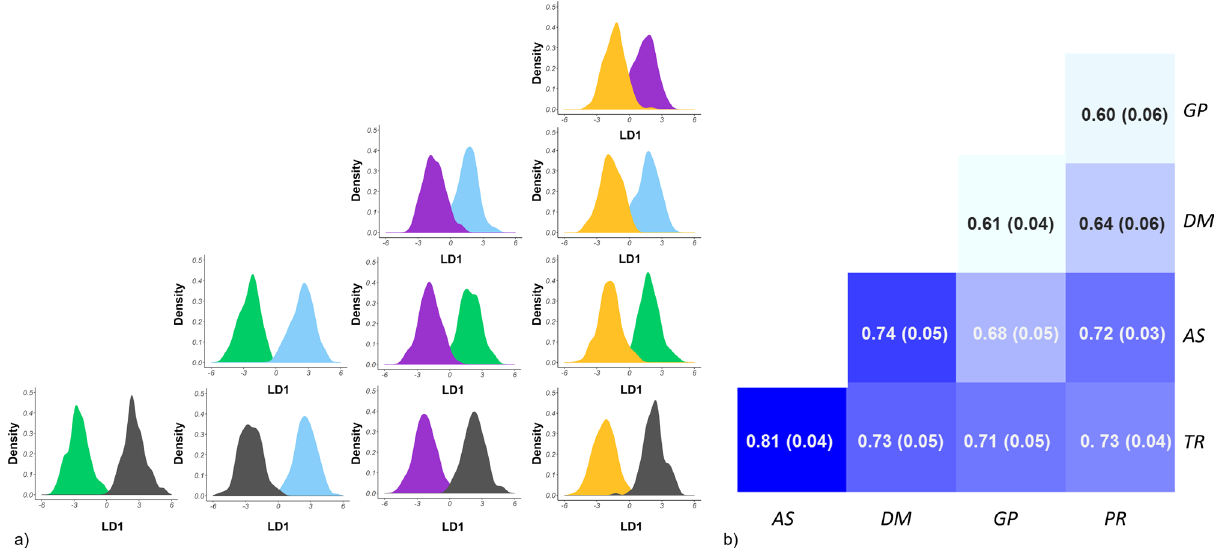
Figure 4. ( a ) Density plot based on the first discriminant function for each pairwise comparison; each subgroup is code colored as follows: AS = Asiago, green; DM = Drinkable Milk, light blue; GP = Grana Padano, violet; PR = Parmigiano Reggiano, yellow; TR = Trentingrana, dark grey. ( b ) Heatmap of the external validation (80:20) per each pairwise comparison using the function heatmap.2 from the R package gplots 39 (http:// cran.r- proje ct. org/ web/ packa ges/ gplots/ index. html) in R (version 4.0.3) 32 . The average value is presented within each square and the standard deviation within